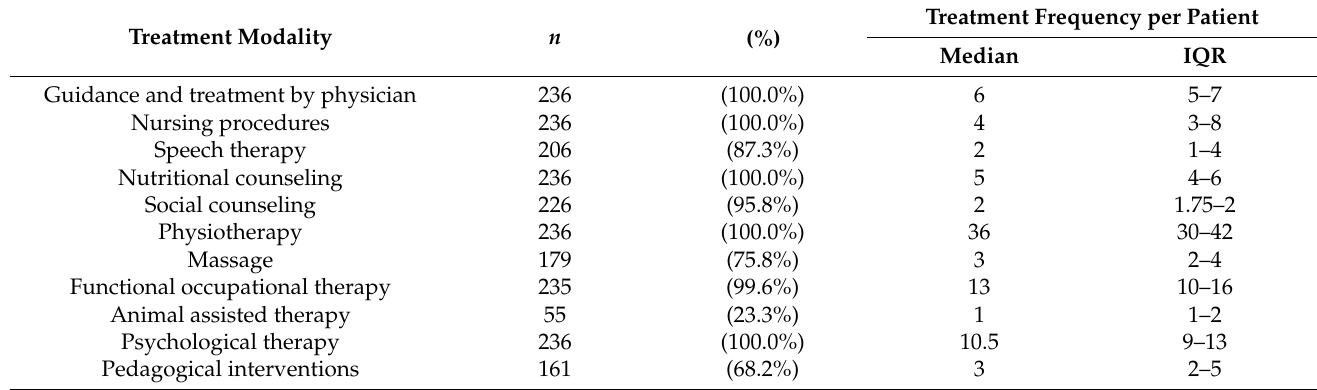
Table 1. Treatment modalities: overview over therapeutic measures per patient during the